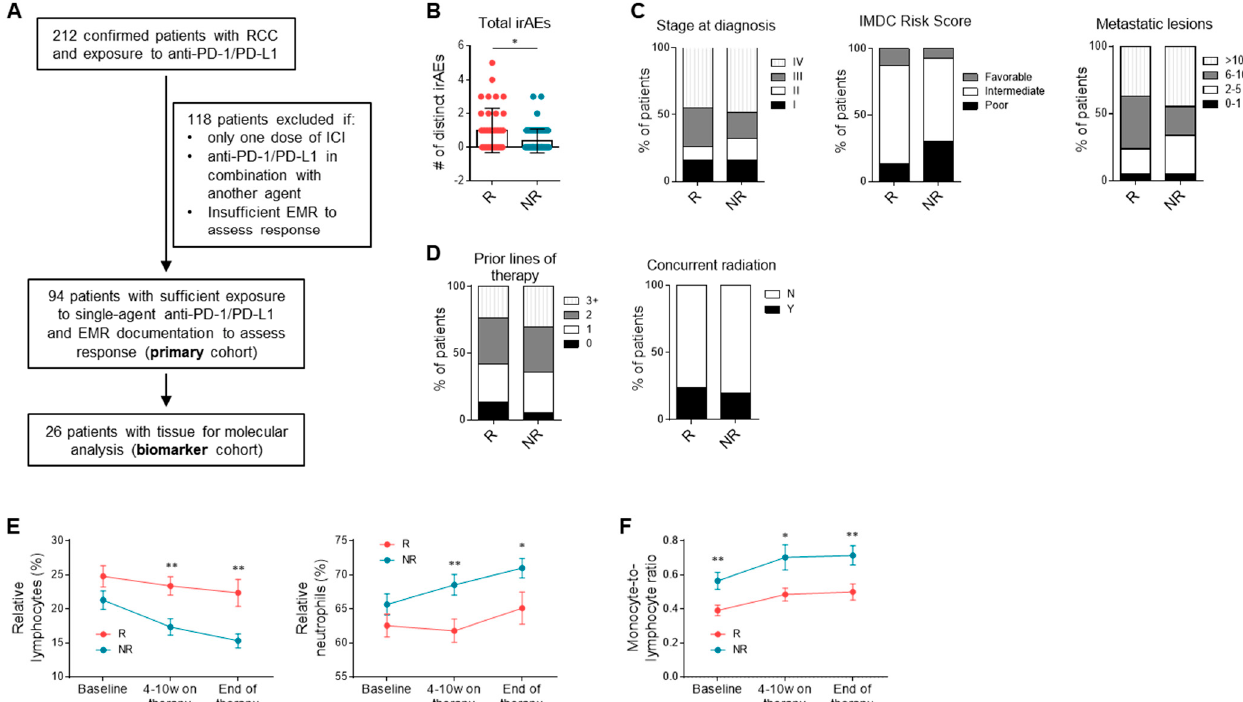
Figure 1. Clinical correlates and response to single-agent anti-PD-1/PD-L1. ( A ) Flow diagram depicting subdivision of primary and biomarker patient cohorts. ( B ) Number of immune-related adverse events (irAEs) experienced by responders and non-responders. Data shown are averages ± standard deviation (SD). * p < 0.05, unpaired Mann–Whitney U-test ( n = 38, 56). ( C ) Stage at diagnosis, International Metastatic RCC Database Consortium (IMDC) risk score, and number of metastatic lesions of at initiation of ICI therapy. ( D ) Prior lines of therapy before ICI therapy, as well as concurrent radiation during ICI therapy. ( E ) Percentage of lymphocytes (two-way analysis of variance (ANOVA): response effect, p < 0.0001; time effect, p = 0.012; interaction, p = 0.44) and neutrophils (response effect, p = 0.0002; time effect, p = 0.063; interaction, p = 0.55) in peripheral blood of responders compared to non-responders at baseline, 4 to 10 weeks of therapy, and end of therapy ( n = 37, 53). Data shown are averages ± SEM. * p < 0.05, ** p < 0.01, post-hoc two-tailed unpaired Welch’s t test, uncorrected for multiple comparisons. ( F ) Monocyte-to-lymphocyte ratio (MLR) (response effect, p < 0.0001; time effect, p = 0.047; interaction, p = 0.91) in responders compared to non-responders ( n = 36, 52).